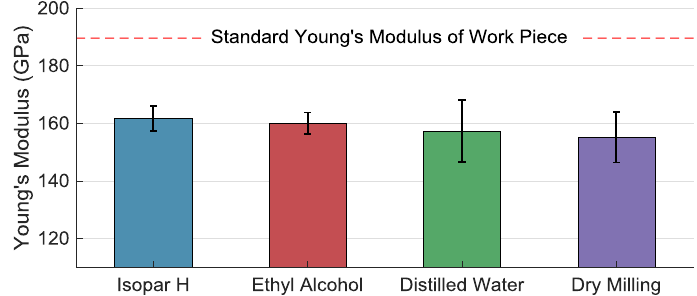
Figure 7. Young’s module of work piece micromilled under different coolants and methods.